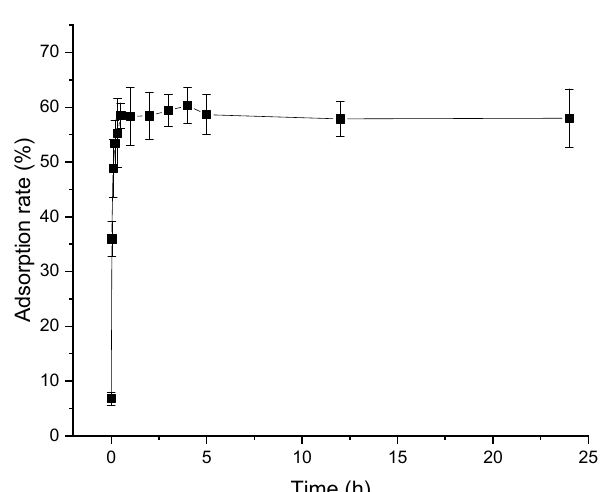
Figure 2. Static adsorption kinetic curve of polyphenols from distiller’s grain with 3 g D101 resin under 30 °C at 120 rpm for 24 h. Vertical bars represent the standard deviation of each value.